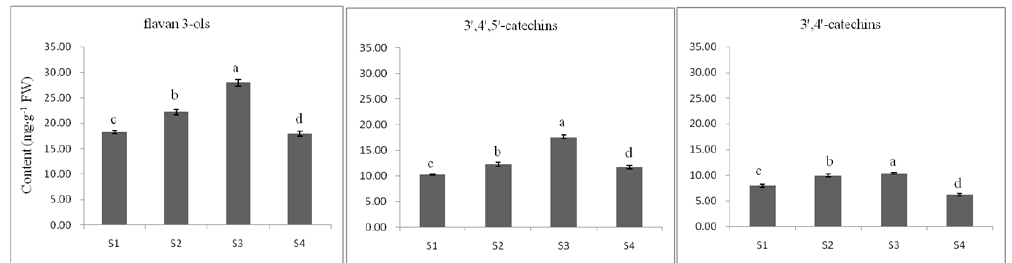
Figure 7. Cont. Figure 7.